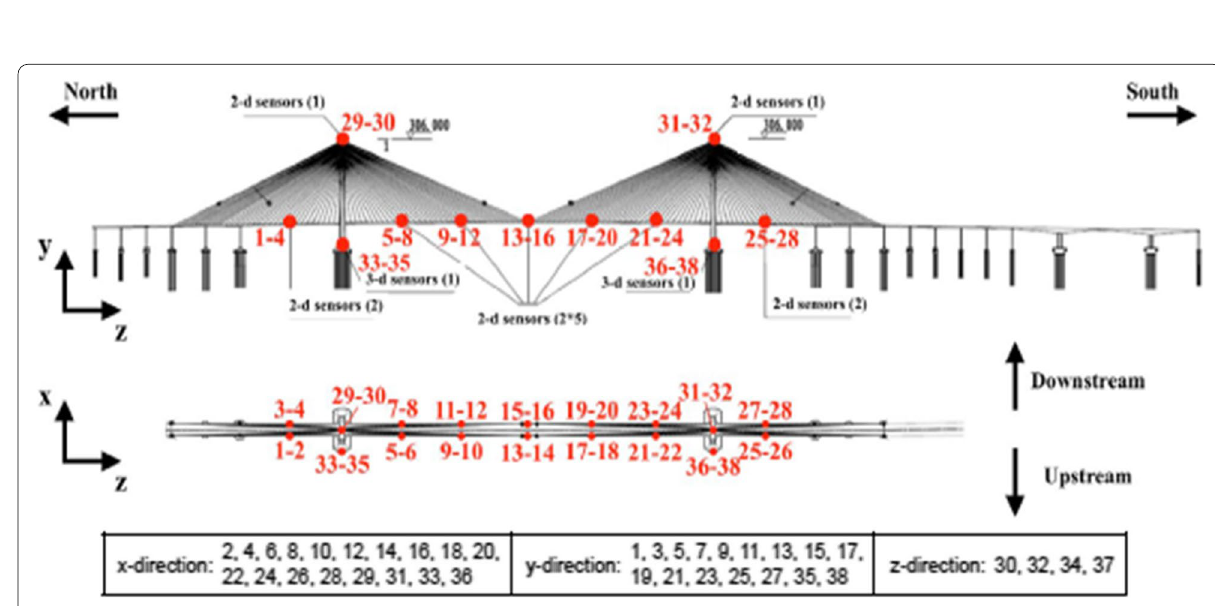
Fig. 4 The bridge and placement of the accelerometers on the deck and towers (IPC-SHM 2020)